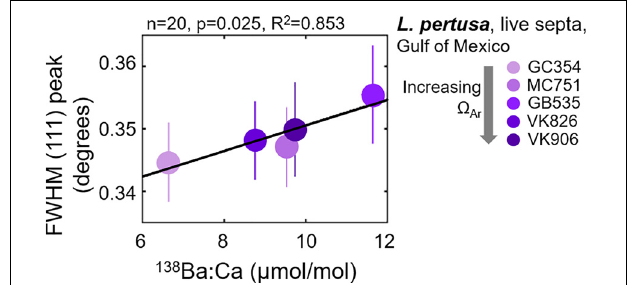
Frontiers in Marine Science |